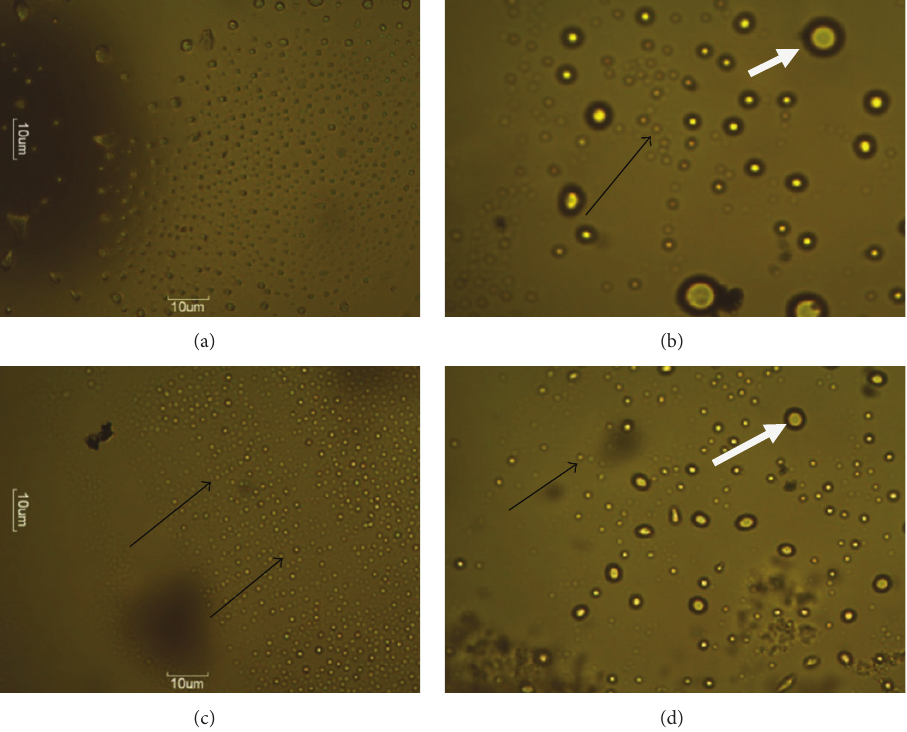
Figure 4: Effect of S. birrea acetone extract on MCF-7 cells at 24h and subjected to acridine orange (Life technology, South Africa) and propidium iodide staining. (a) Negative control of untreated cells depicting viable cells (green nucleus), (b) cells treated with positive control curcumin (60 𝜇 M), showing late apoptosis (thick arrow), (c) treated cells with IC 50 (87.6 𝜇 g/mL) concentration indicating early apoptosis (thin arrow), and (d) treated cells with IC 50 × 4 showing late apoptosis and secondary necrosis.